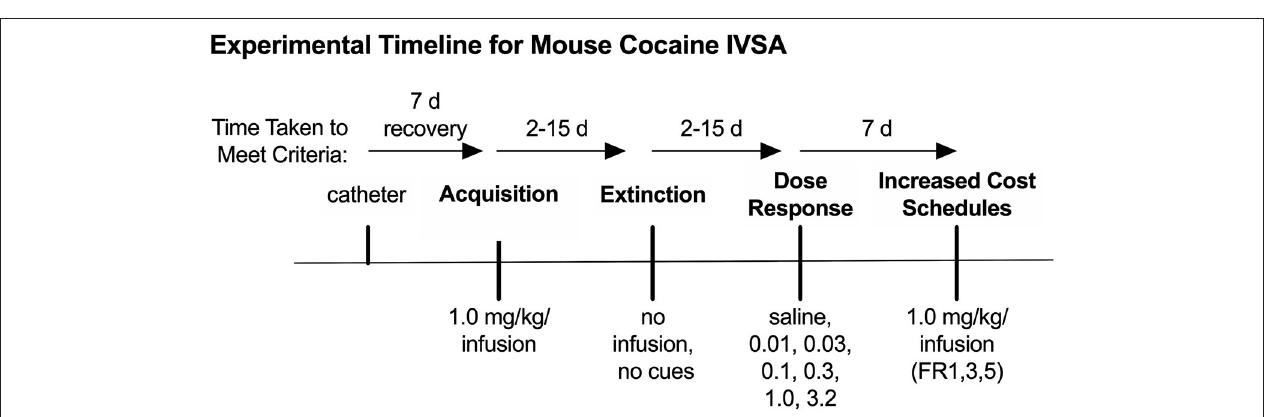
FIGURE 5 | Behavioral timeline for example data. Timeline for the example IVSA experiment, including acquisition, extinction, dose-response, and increased cost schedule phases of testing. Modified from Huebschman et al., 2021, with permission from Wiley and the Federation of European Neuroscience Societies. The figures include data collected with support from the NIDA Drug Supply Program (gifted drug) and Texas A&M University